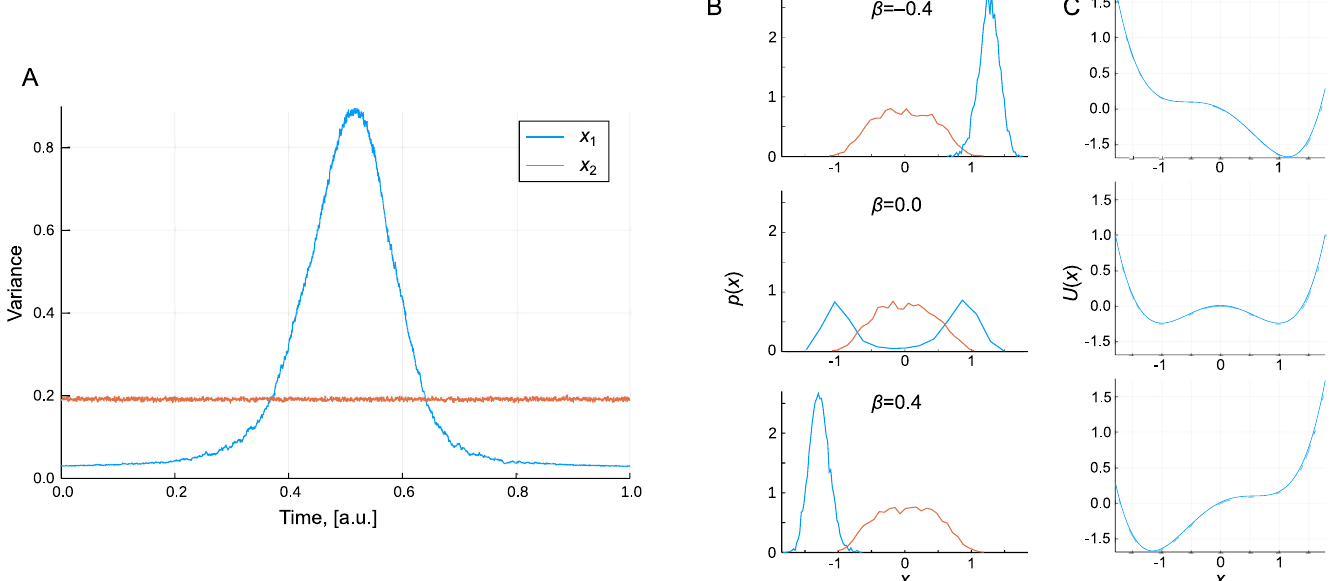
Fig 3. The transition state in a transitory landscape. (A) The variance of the two states across 5000 simulations in which β is linearly varied with time; (B) Probability distributions of the two states at three different values of β ; (C) The potential U at each of the three values of β . The high variance “transition state” corresponds to intermediate values of β in which significant bistability generates large heterogeneity.